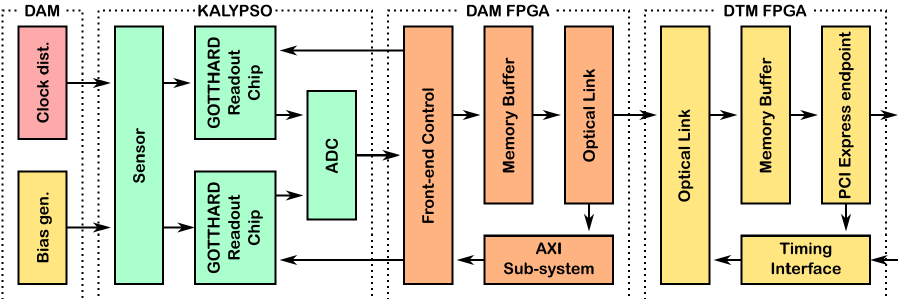
Figure 2. An overview of the HOLD